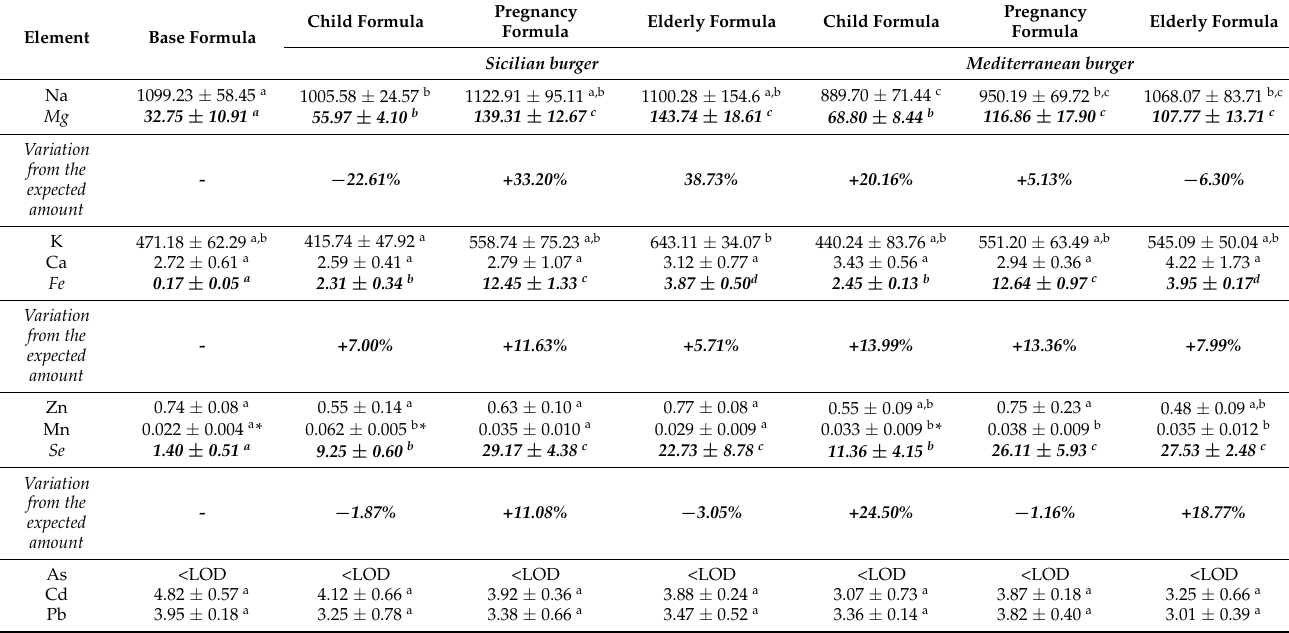
For control and treated burgers: different superscript letters in the same row indicate significantly different values for a given parameter ( p < 0.05 by post hoc Tukey’s HSD test); the same superscript letters in the same row indicate not significantly different values for a given parameter ( p > 0.05 by post hoc Tukey’s HSD test). For a given fortification formula: * indicates significantly different values between Sicilian and Mediterranean burgers ( p < 0.05 by Student’s t